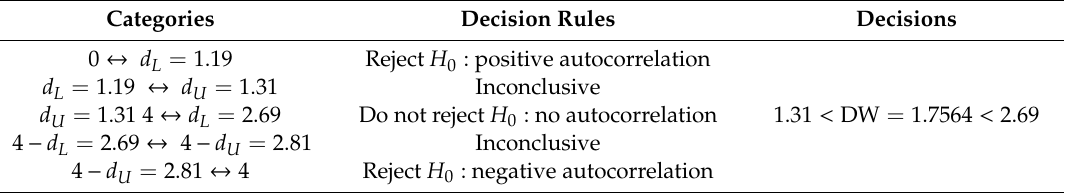
Figure 8. Scatter plot of phase-I sample and the Shewhart chart with estimated parameters. Table 9. Interpretation of Durbin–Watson autocorrelation test.